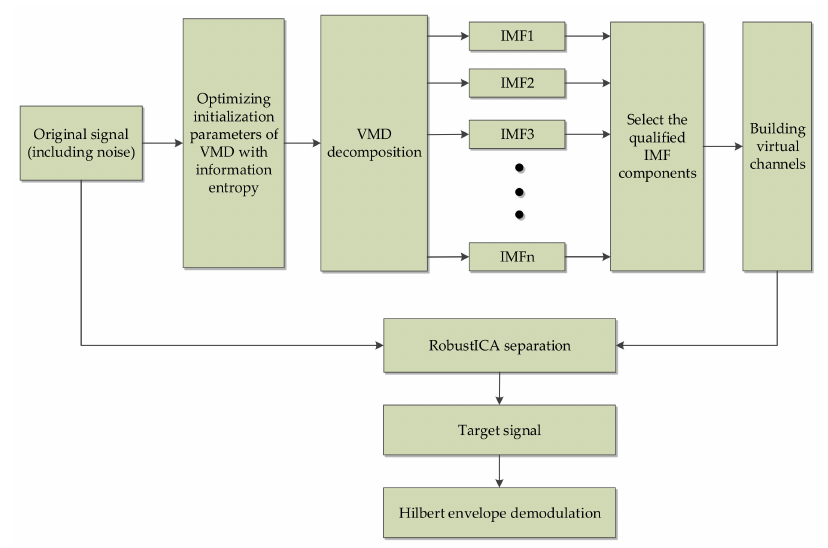
Figure 3. Fault feature extraction method based on VMD optimized with information entropy and